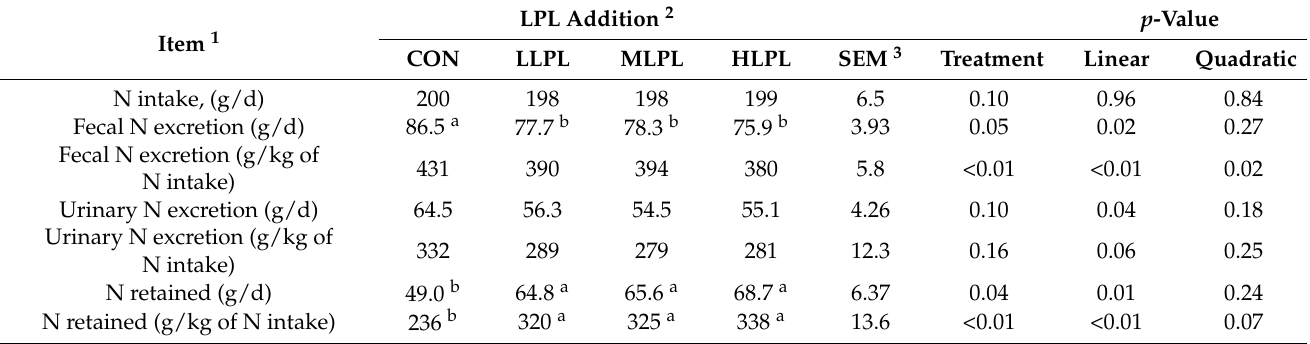
Table 3. Effect of dietary lysophospholipid supplementation on nitrogen utilization in beef